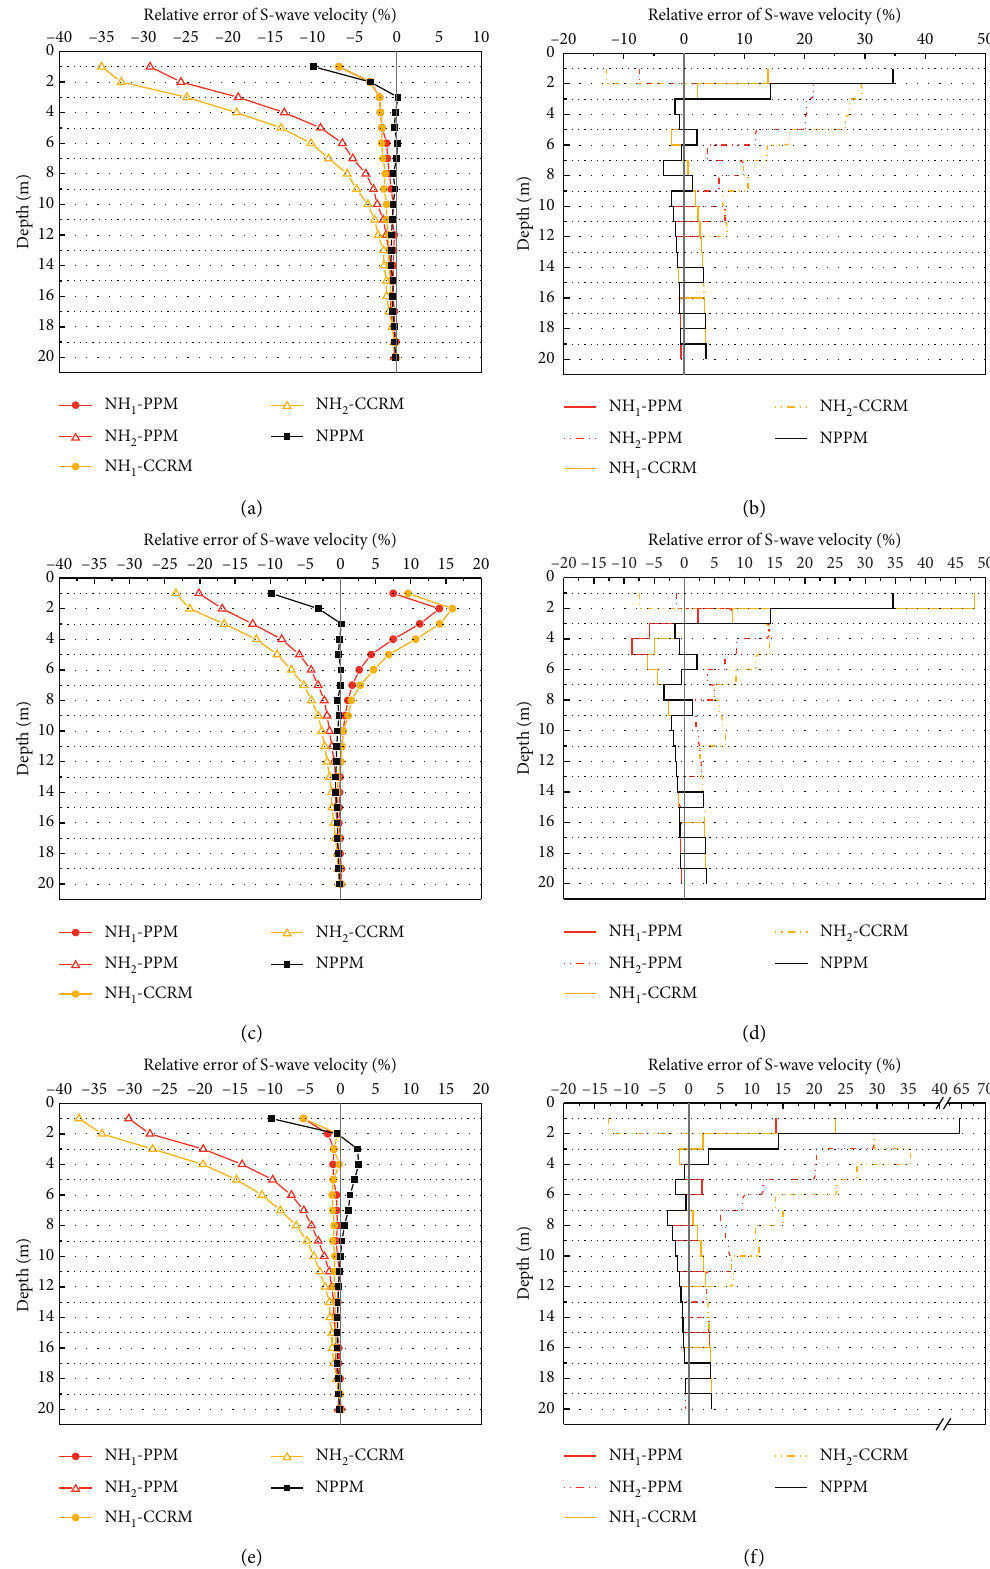
Figure 5: Relative error of V S of PPM, CCM, and NPPM at different testing depths: (a) excitation inclination 20 ° , geophone deflection 20 ° , and geophone inclination 10 ° , using the trigger signals; (b) excitation inclination 20 ° , geophone deflection 20 ° , and geophone inclination 10 ° , based on the adjacent received signals; (c) excitation inclination 20 ° , geophone deflection 50 ° , and geophone in- clination 10 ° , using the trigger signals; (d) excitation inclination 20 ° , geophone deflection 50 ° , and geophone inclination 10 ° , based on the adjacent received signals; (e) excitation inclination 45 ° , geophone deflection 20 ° , and geophone inclination 10 ° , using the trigger signals; (f) excitation inclination 45 ° , geophone deflection 20 ° , and geophone inclination 10 ° , based on the adjacent received